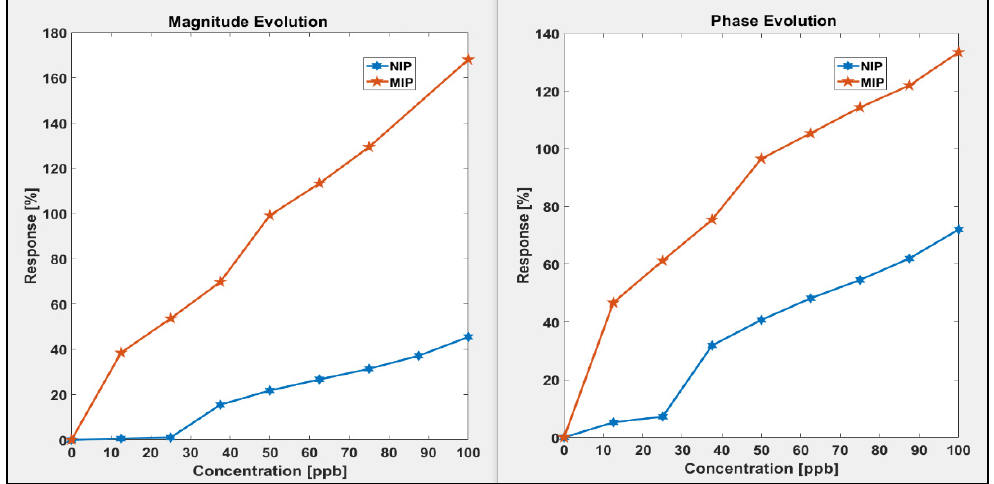
Figure 7. Sensor’s magnitude ( left ) and phase ( right ) responses versus penicillin G.